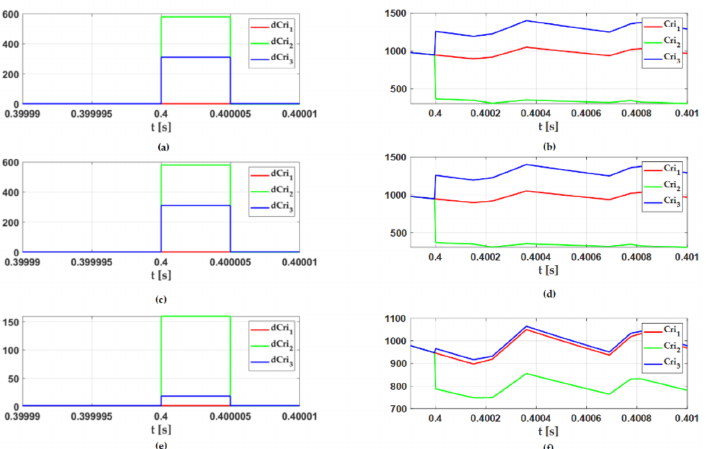
Figure 9. Marker transients in phase A under lack of signal ( b ), intermittent signal ( d ), variable gain ( f ) and their errors, respectively ( a , c , e ) in scalar control.